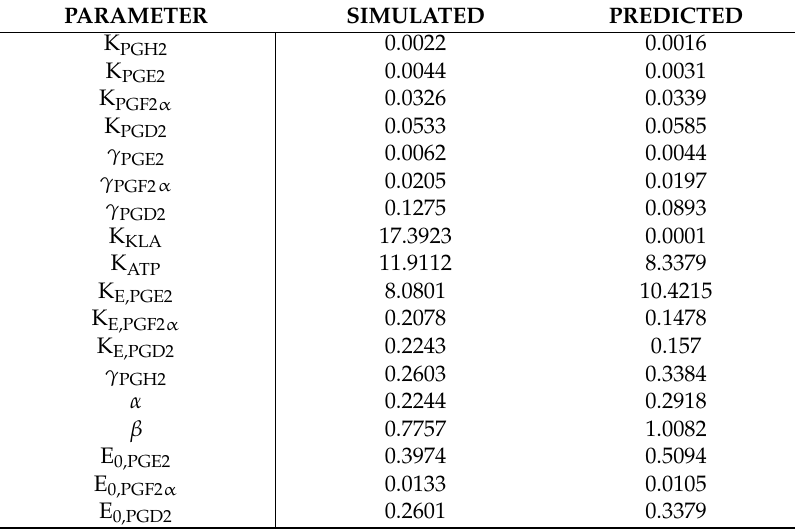
Table A1. Reaction parameters were estimated for the eicosanoid metabolism model. The simulated and predicted columns refer to the parameters optimized for ATP stimulated BMDM cells and KLA primed ATP stimulated BMDM cells, respectively. The predicted parameters were further optimized from the simulated parameters within 30%